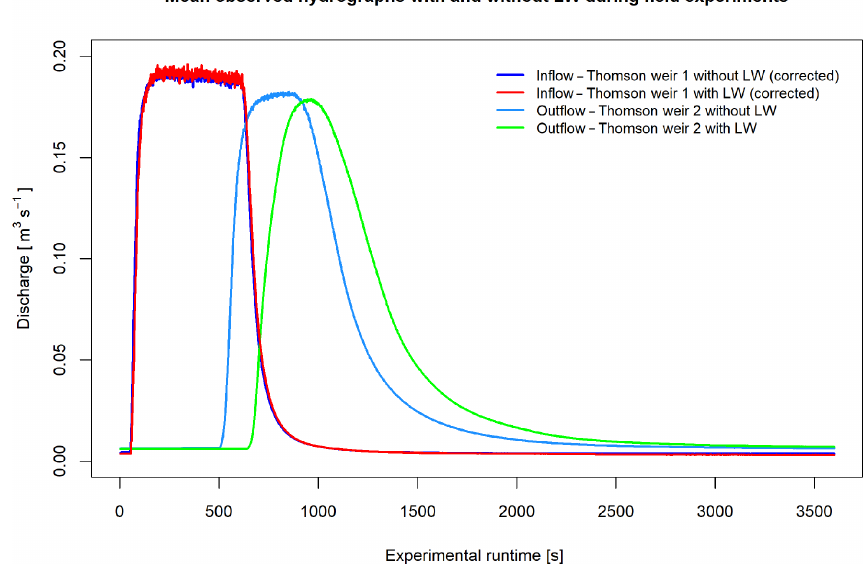
Figure 5. Average measured and corrected flood hydrographs observed during field experiments with and without stable in-channel large wood at both Thomson weirs (after Wenzel et al.,